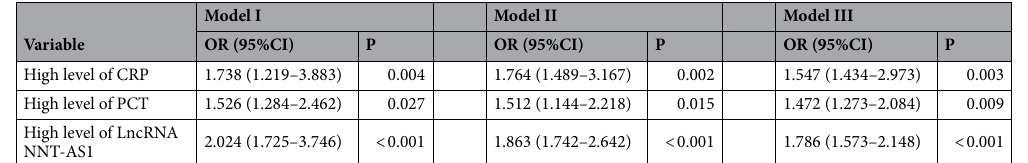
Table 4. Logistic analysis of risk factors for RMPP. Model II: adjusting the fever days, hospital stay days, abnormal signs of lungs on the basis of Model I; Model III: adjusting IgA, IgG on the basis of Model II.